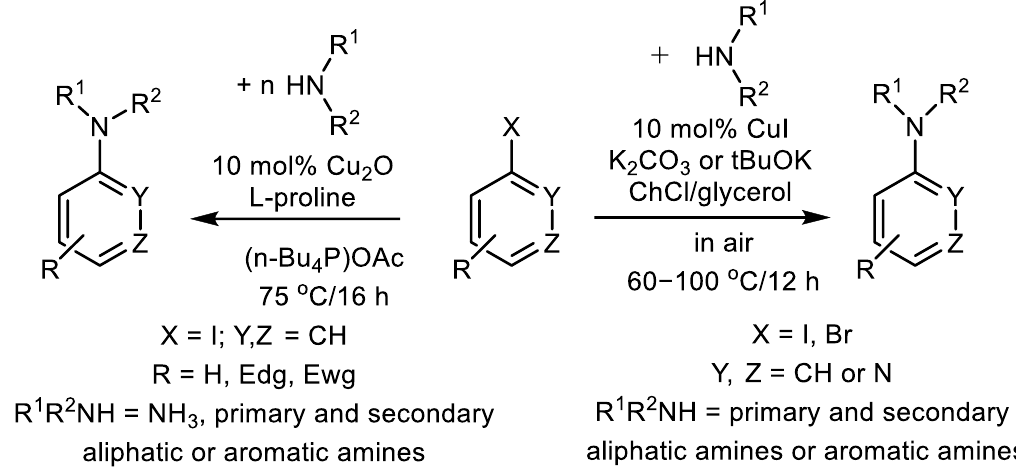
Figure 7. Proposed structure of PS-supported MIM.L-proline-based-Cu-catalyst [104].